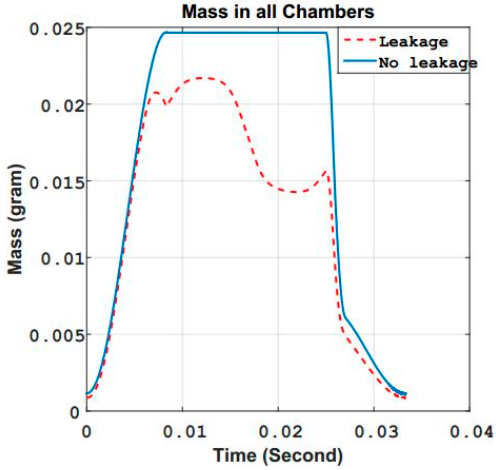
Figure 11. Mass of working fluid vs. time over one cycle (30 Hz).